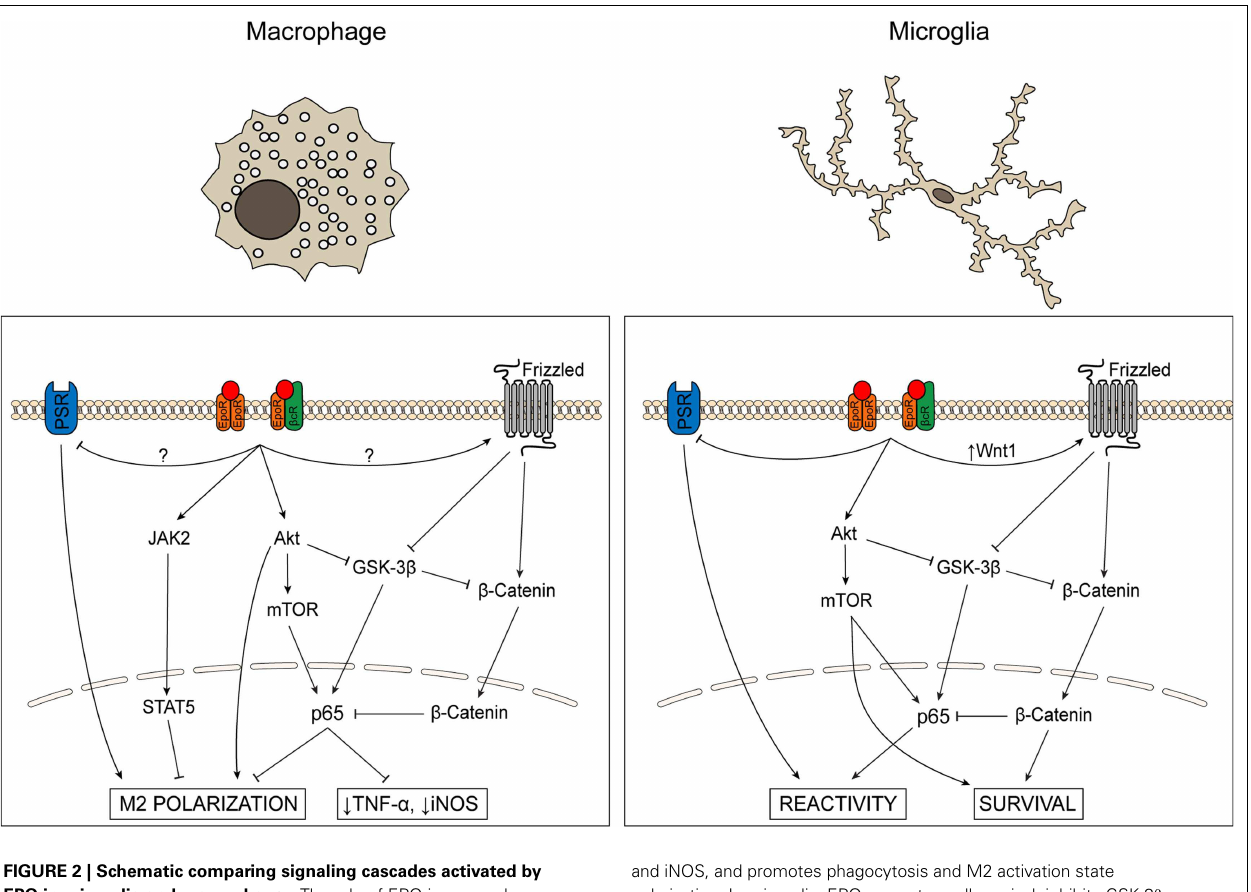
and iNOS, and promotes phagocytosis and M2 activation state polarization. In microglia, EPO promotes cell survival, inhibits GSK-3 β activity, and increases NF- κ B p65 via PI-3K/Akt while simultaneously activating theWnt-1/ β -catenin pathway that results in sequestration of NF- κ B in the nucleus. EPO also decreases PSR levels, suggesting decreased